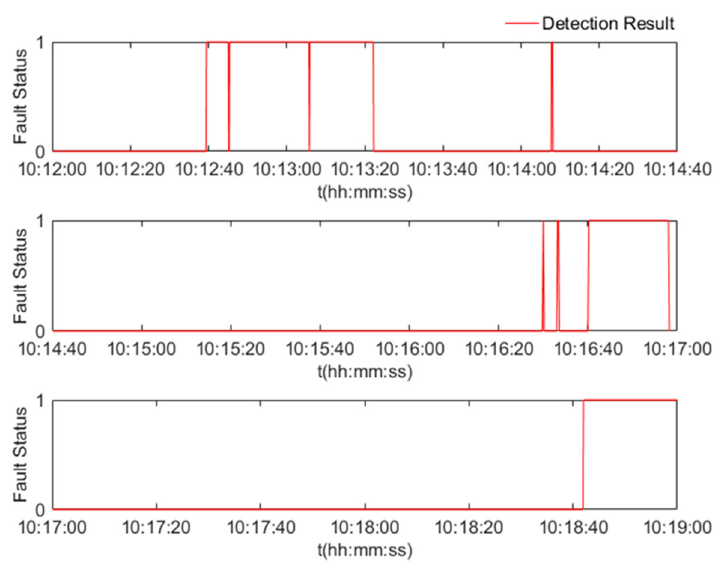
Figure 6. Fault detection results for the velocity fault in the field test. Table 3. Fault detection performance in the defined sessions.